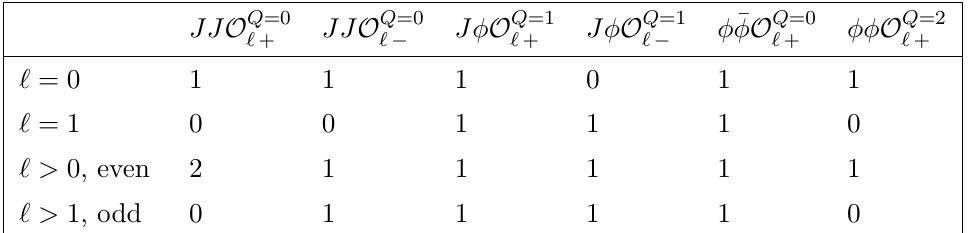
Table 3 . Summary of the number of allowed tensor structures for each three point function in our setup. The labels ‘, ± , Q respectively correspond to spin, parity and U(1) charge of the exchanged